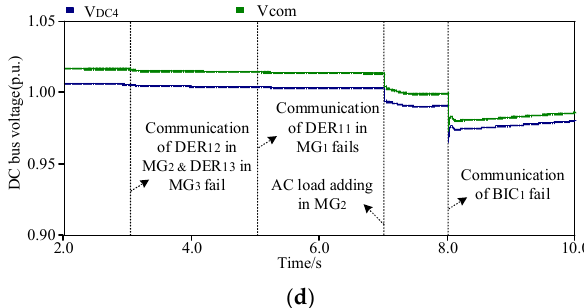
Figure 16. Performance of proposed strategy under communication failure: ( a ) Output power of AC/DC DERs, ( b ) Output power of BICs, ( c ) Frequencies of AC MGs, ( d ) Voltages of common bus and DC MG.